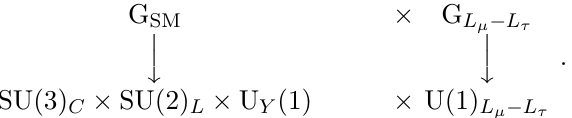
Figure 1 . Diagrams contributing to the kinetic mixing between the hypercharge gauge boson ^ B and the U(1) L gauge boson ^ X (cid:22) . (cid:22) (cid:0) L (cid:28) where q 2 is the transferred momentum and g (cid:22)(cid:28) the gauge coupling of U(1) L same result holds for U(1) L and U(1) L with the obvious replacements. For (cid:22) (cid:0) L e e (cid:0) L (cid:28)